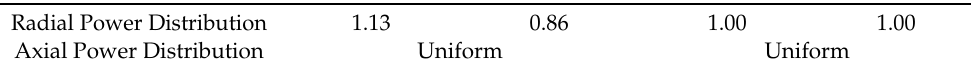
Table 8. 2 × 1 power distributions from the FLOCAL developer benchmark.